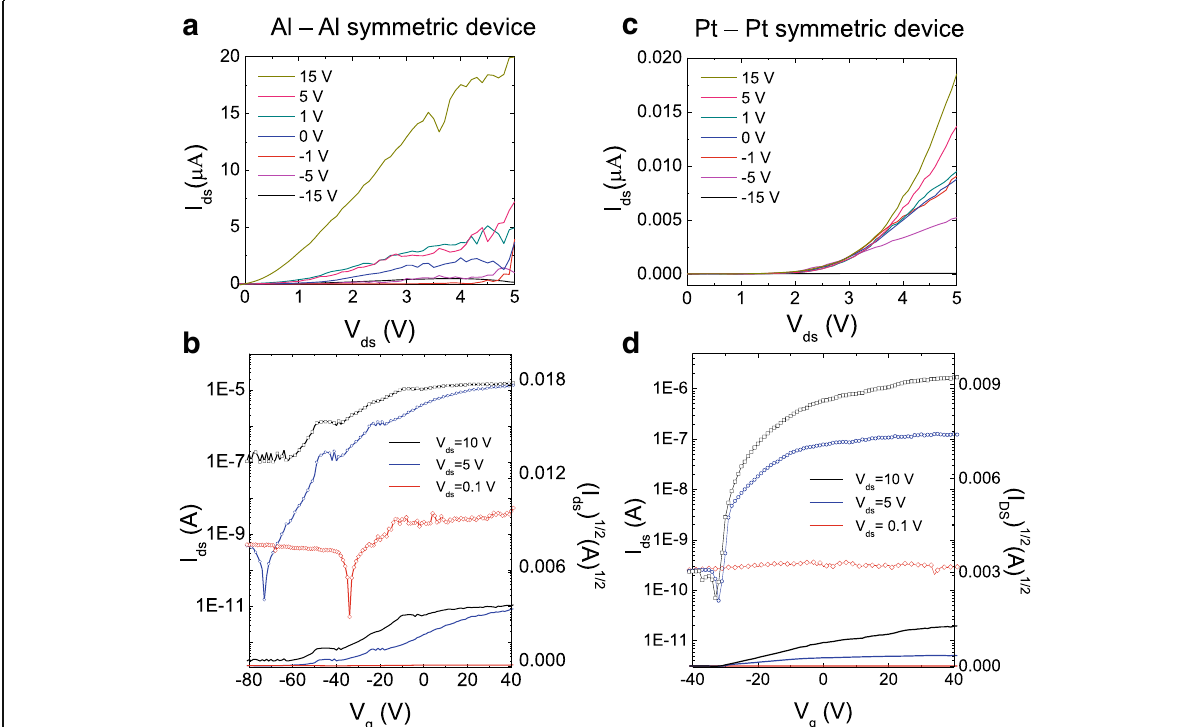
Fig. 2 a Output curve and b transfer curve of the MoS 2 device with Al-Al symmetric electrodes. c Output curve and d transfer curve of the same device with Pt-Pt symmetric